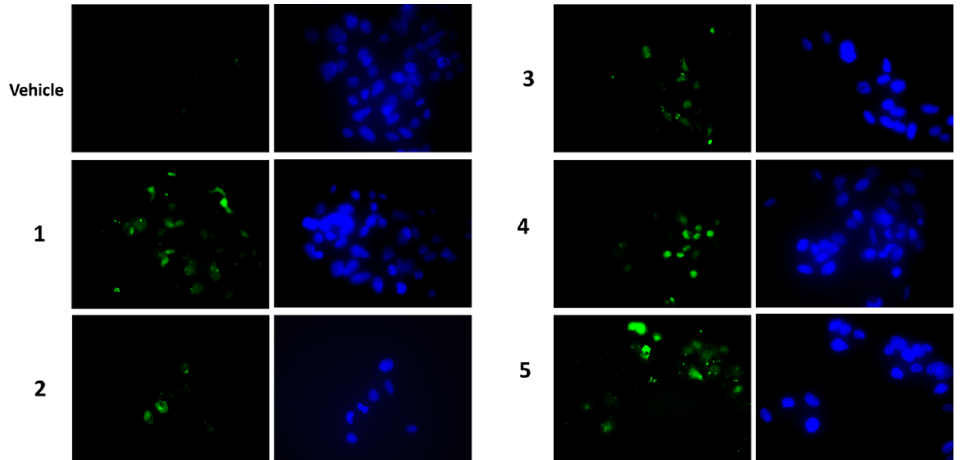
Figure 7. Microscopic detection of apoptosis by the TUNEL assay in HepG2 cells treated with 1 μ M of each compound, or vehicle only, for 24 h. Apoptotic nuclei are in green (on the left), total Hoechst- stained nuclei are in blue (on the right). Magnification 40×, with oil.